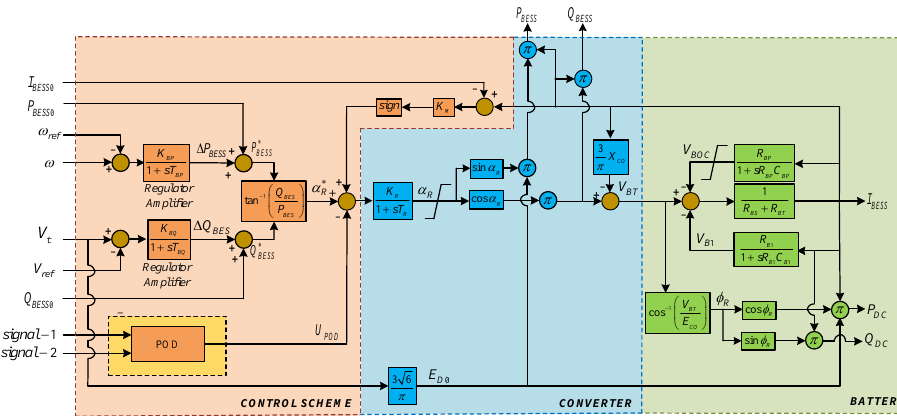
Figure 5. Schematic diagram of fifth-order model BESS with POD.